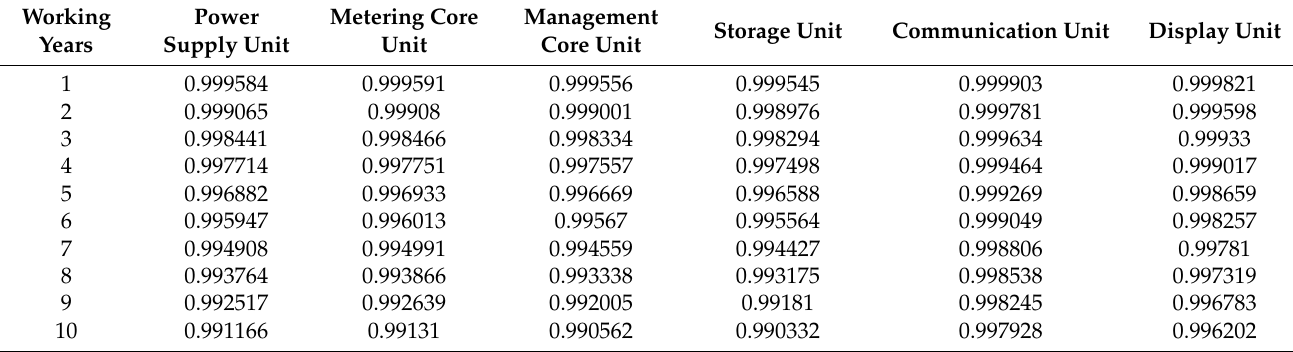
Table 9. Dynamic reliability of each unit after allocation.